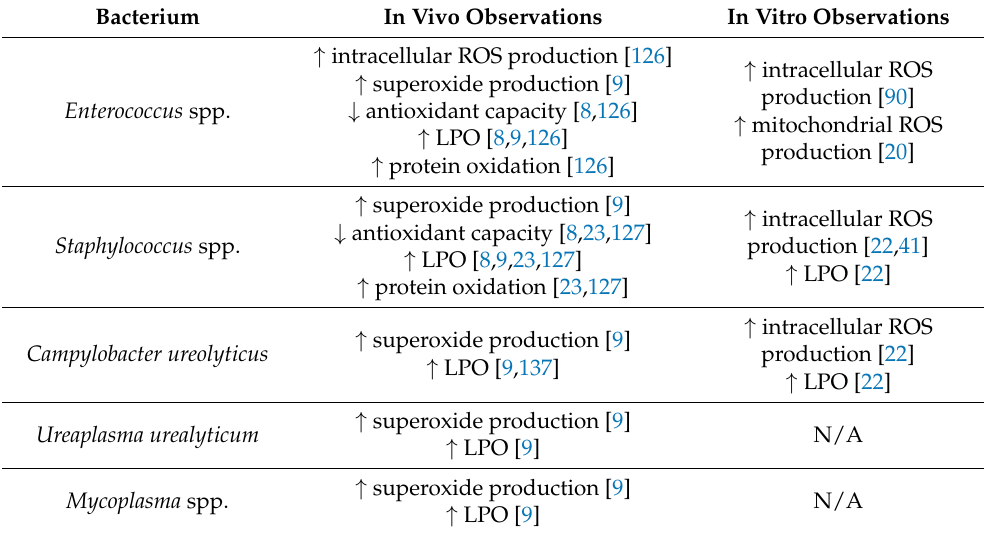
Table 2. Cont. Bacterium In Vivo